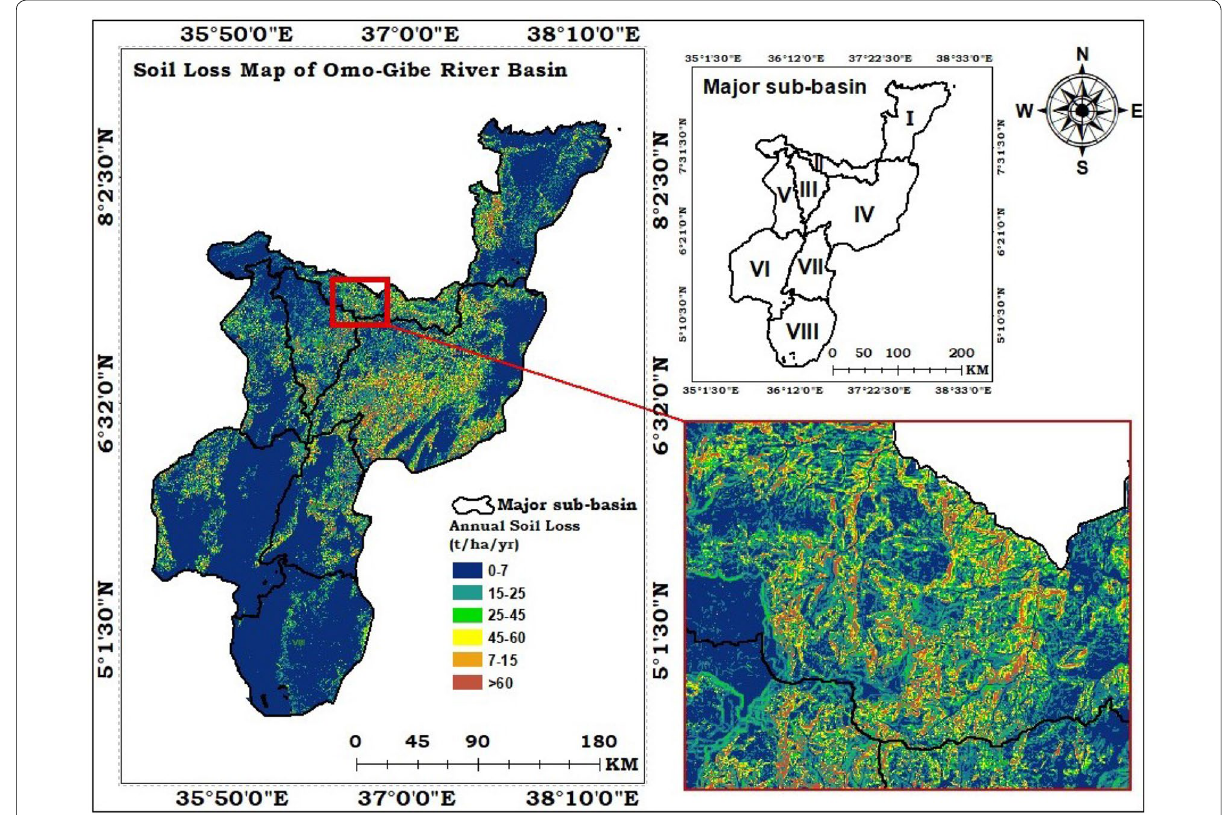
Fig. 8 Spatial distribution soil erosion loss (severity map) in Omo-Gibe river